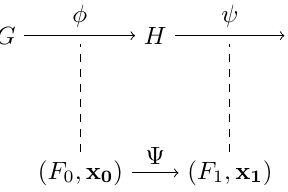
Figure 3. Graph composition and resulting